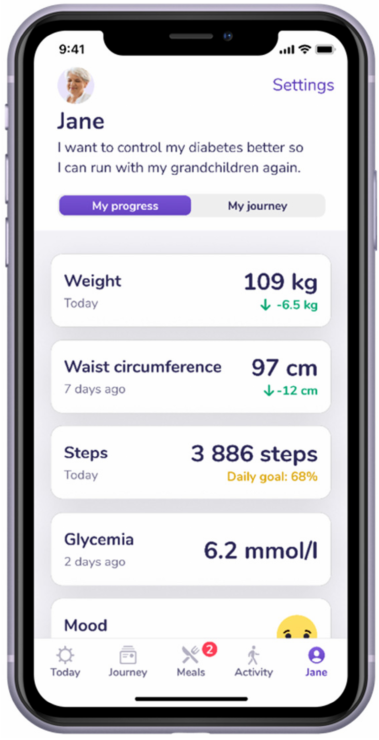
Figure A3. Tracking of health